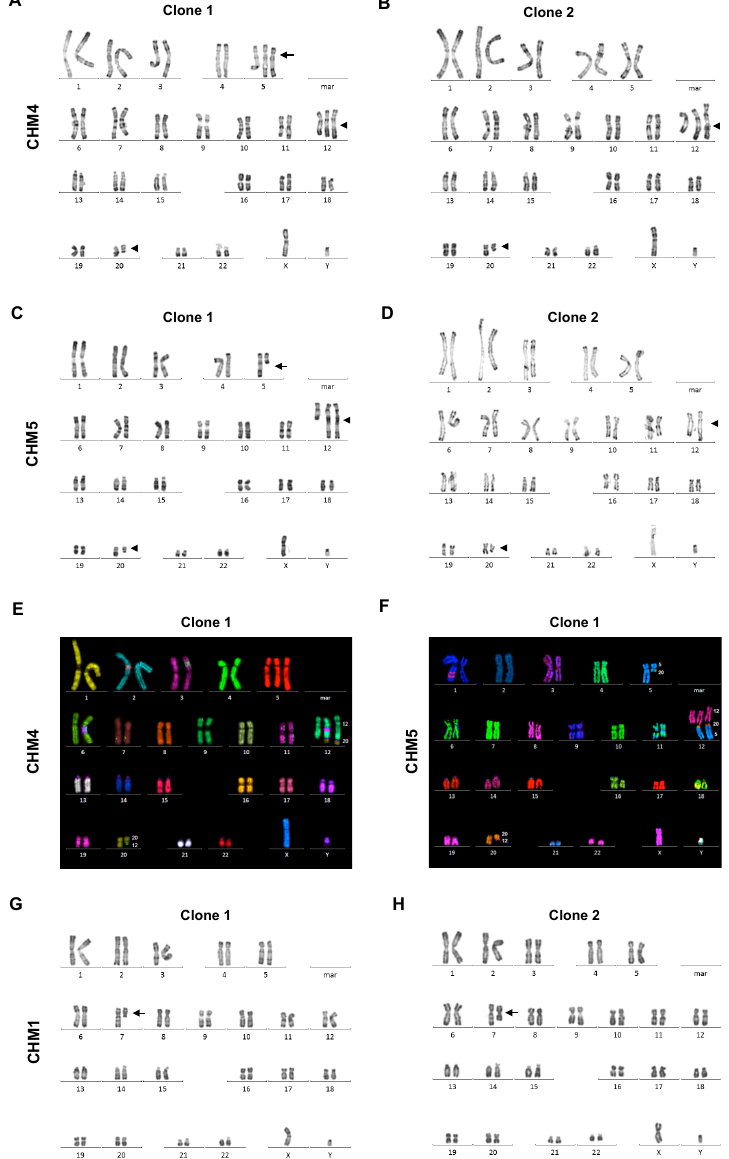
Figure 3. Genetic instability of the generated iPSCs. ( A ) RHG banding of clone 1 of CHM4 detected a trisomy of chromosome 5 (arrow) and translocation between chromosome 12 and chromosome 20 (arrowheads). The rearranged chromosome 12 was duplicated. ( B ) RHG banding of clone 2 detected the same rearrangements of chromosomes 12 and 20, including a duplication of the derivative chromosome 12 (arrowheads), whereas no rearrangement of chromosome 5 could be detected. ( C ) RHG banding of clone 1 of CHM5 detected a loss of the long arm of chromosome 5 (arrow) and the same translocation between chromosome 12 and chromosome 20 (arrowheads) detected in (A). ( D ) RHG banding of clone 2 exclusively detected the translocation between chromosomes 12 and 20 (arrowheads). ( E ) Multicolor FISH of the clone 1 of CHM4 shows the trisomy 5 in red, a normal